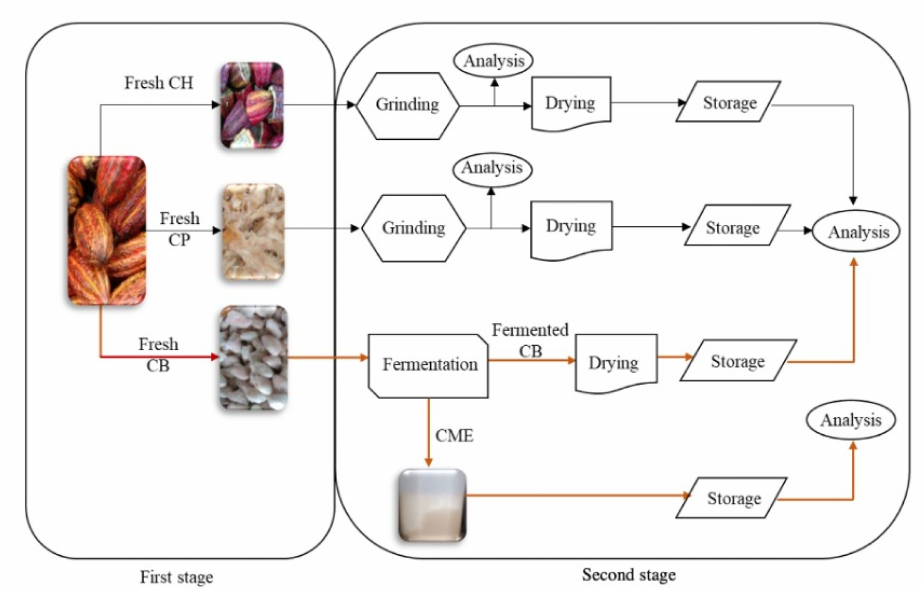
Figure 3. General scheme of cacao-fruit processing for this work.